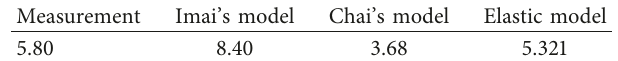
Table 6: Settlement of Johnson’s model